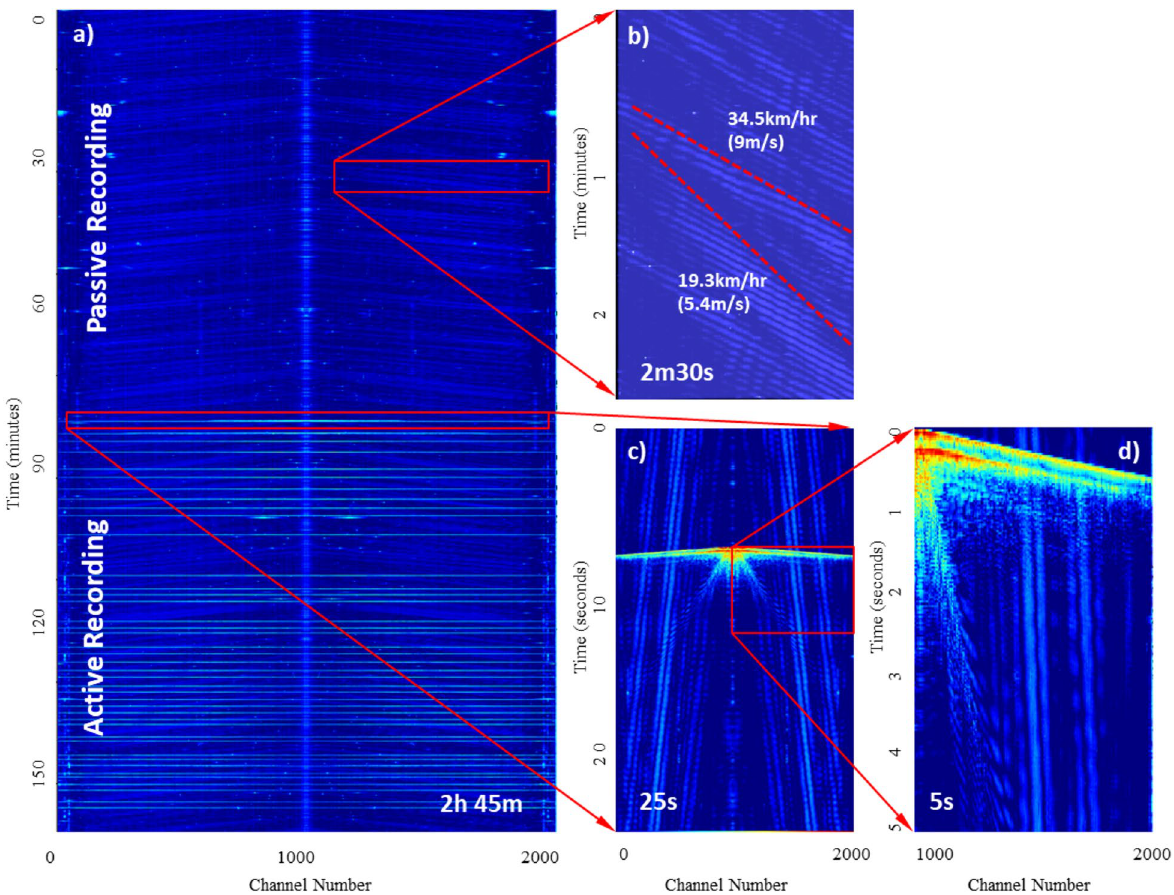
Figure 2. DAS data from site 1 showing ( a ) 2 h 45 min waterfall FBE data with passive and active data recording. ( b ) 2.5 min passive data showing ocean pressure waves, with apparent group wave velocities highlighted (red dashed lines). ( c ) 25 s active data showing airgun shot with pressure wave interference. ( d ) 5 s shot record on 900